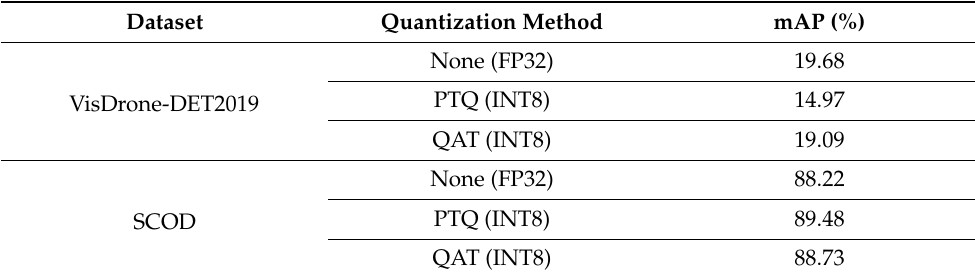
Table 3. Comparison of detection performance according to quantization